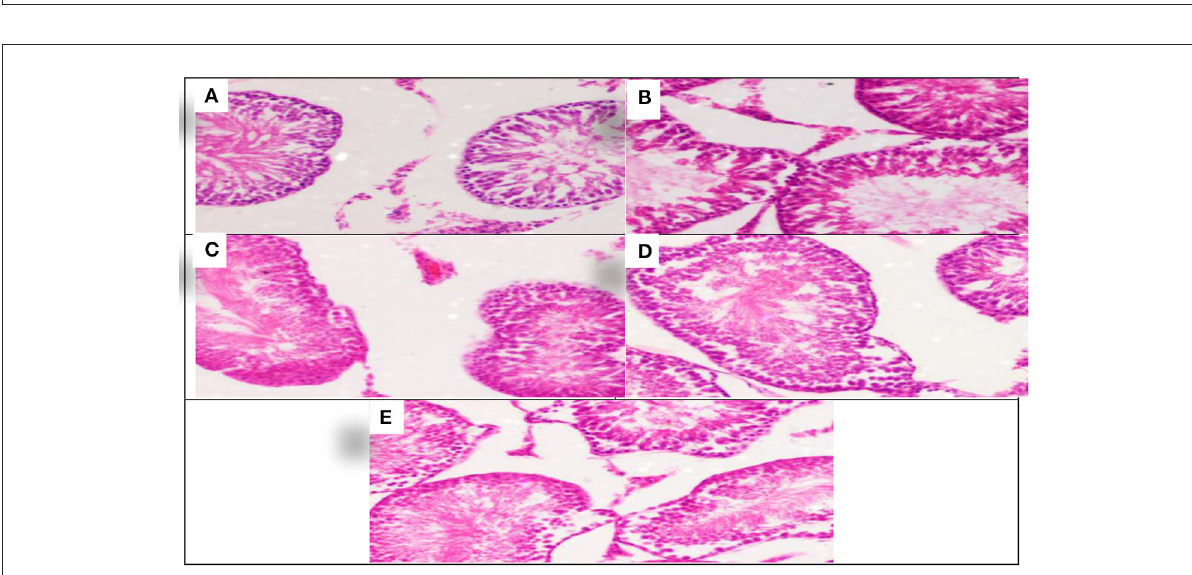
FIGURE4 Schematic diagram showing the effect of each aluminum, medicinal plant, and mix with aluminum and medicinal plants on histopathology of rats’ Tests 60 days after treatment. (A) Control group. (B) 1,600 ppm Aluminum. (C) 1,600 ppm Aluminum + Allium sativum 5%. (D) 1,600